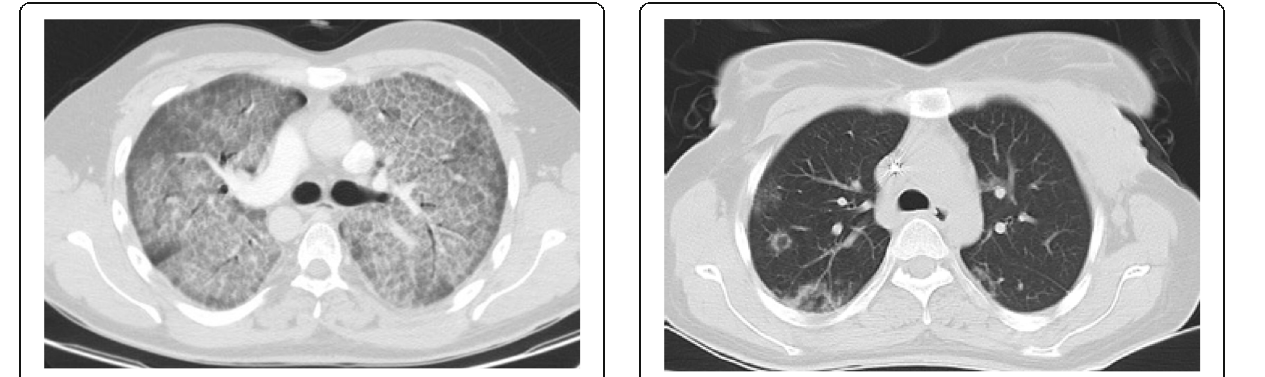
Fig. 8 COVID-19 pneumonia: thin section CT shows multifocal peripheral GGO, with reverse halo appearance